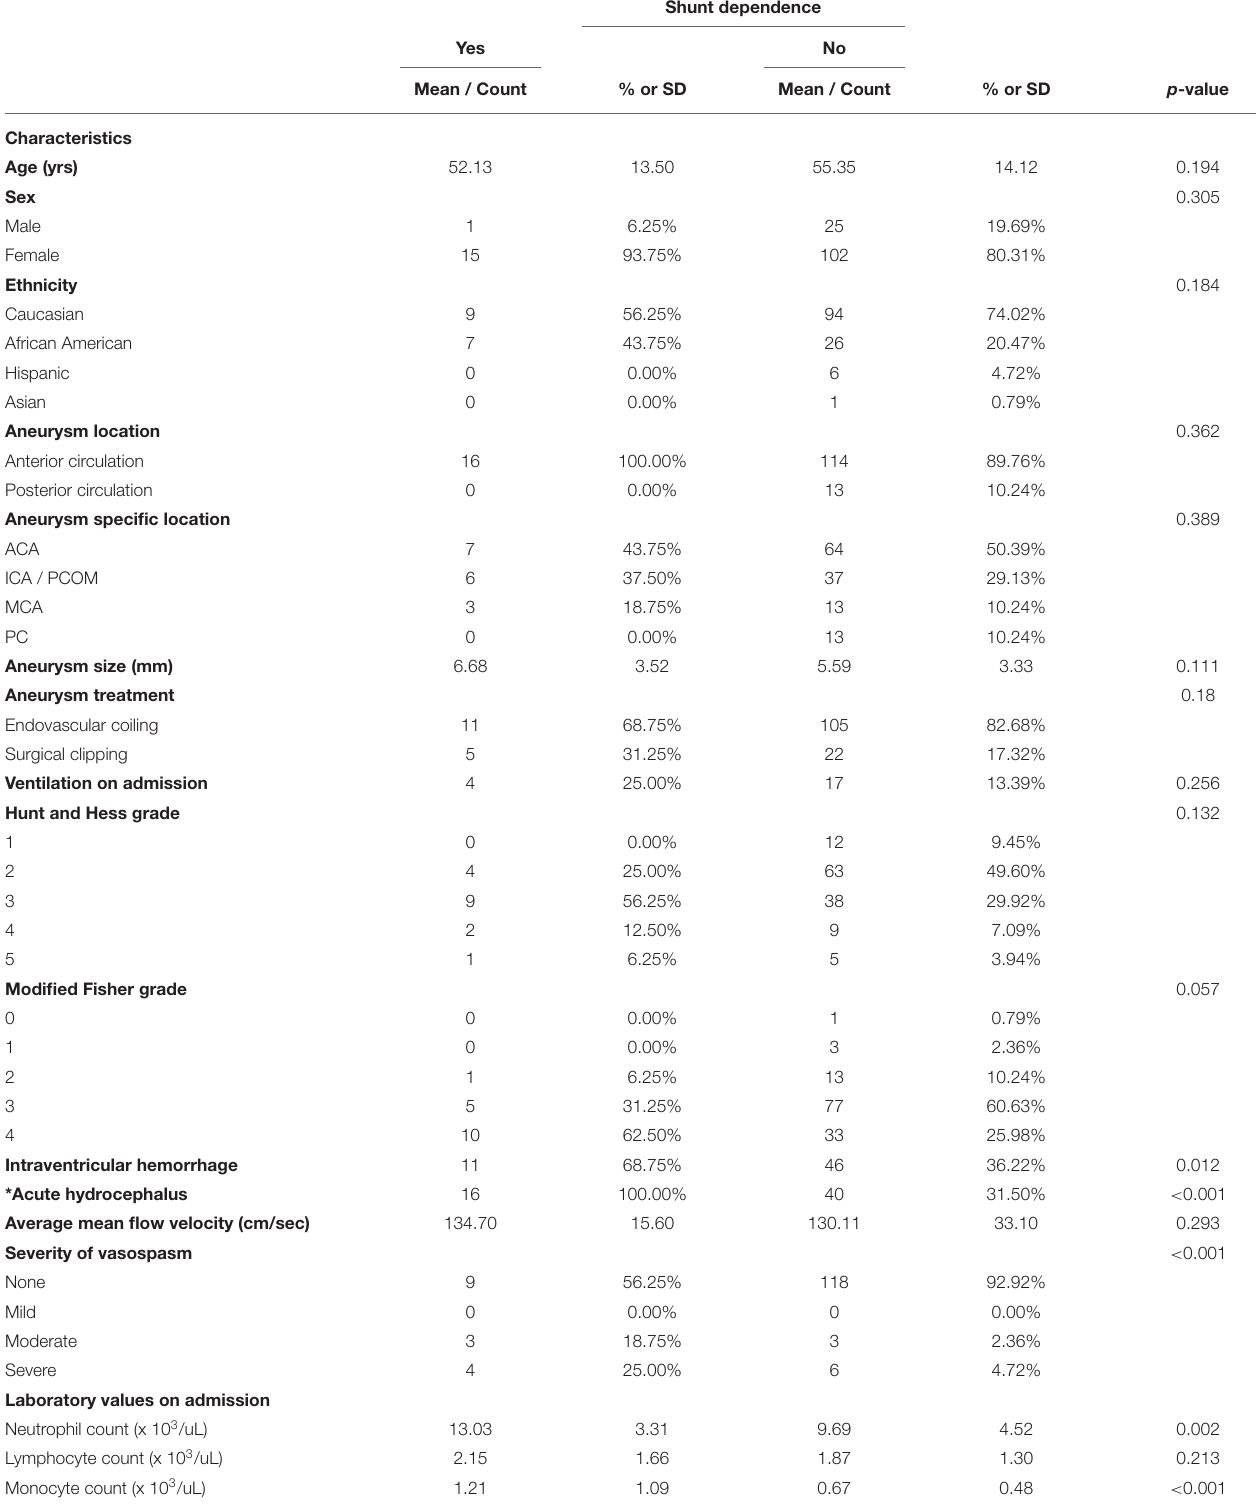
TABLE 1 | Univariate analysis of predictors of shunt dependence after aneurysmal subarachnoid